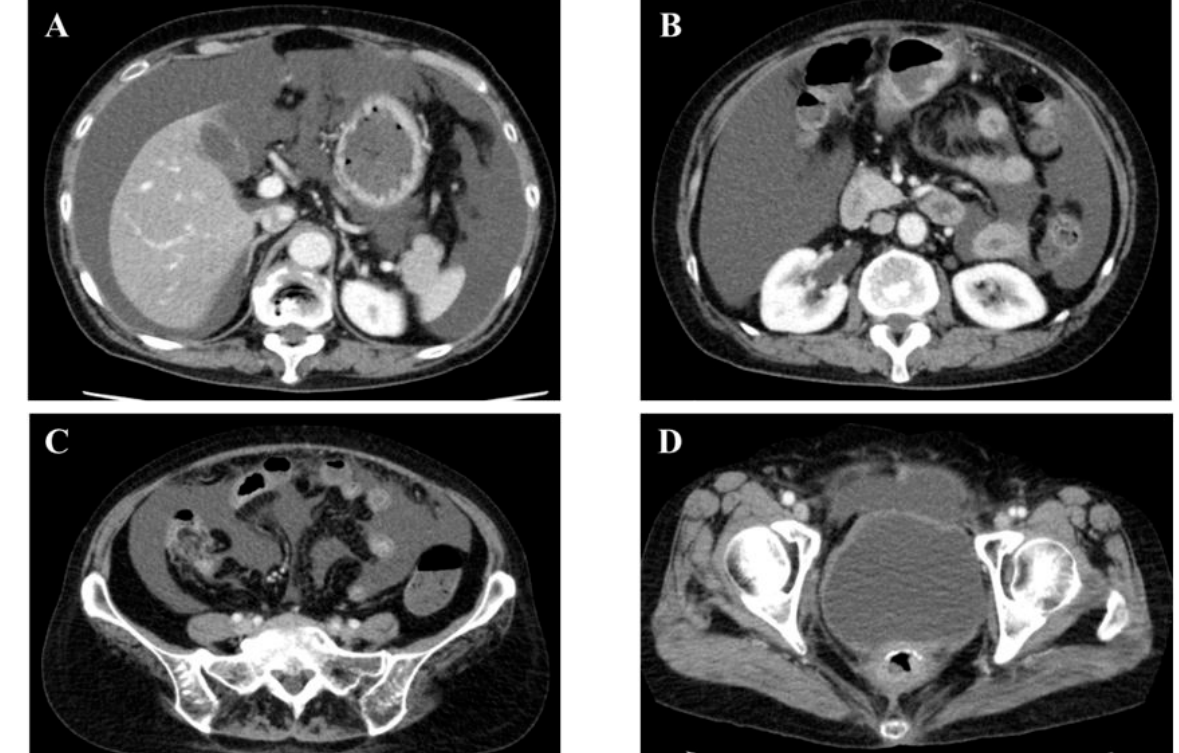
Figure 1. Abdominal contrast-enhanced computed tomography on day 4 of 1st admission. ( A – D ): Abdominal contrast- enhanced computed tomography showed only massive ascites. There were no gastrointestinal perforations, malignant tumors, or urinary abnormalities.